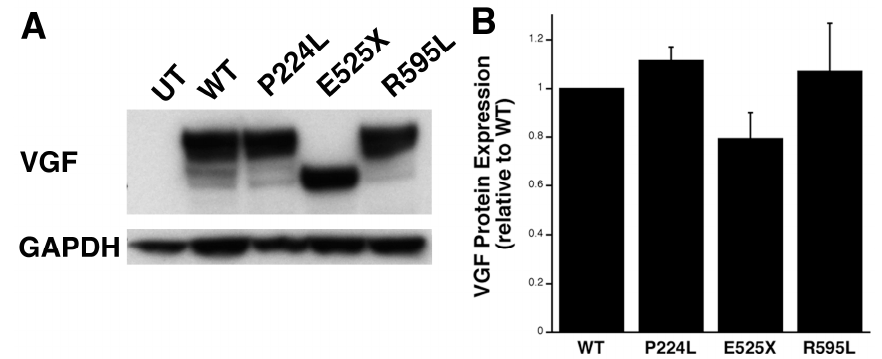
Figure 5. VGF Single Nucleotide Polymorphism (SNP) E525X results in truncated protein. ( A ) Representative Western blot of protein lysates from Human Endothelial Kidney (HEK) cells transfected with VGF plasmid containing either a mutation representing the P224L, E525X or R595L SNPs or Wild Type (WT) VGF , or Untransfected (UT). The blot was probed with VGF antibody and GAPDH was used as a loading control; and ( B ) quantification of protein expression for VGF plasmids in HEK cells. Bars represent average VGF protein levels normalized to GAPDH and expressed as a fold change relative to WT ± SEM. ( n = 3). Two-sample t test: WT vs. P224L t(4) = 2.04, p = 0.125. WT vs. E525X t(4) = − 1.80, p = 0.137. WT vs. R595L t(4) = 0.386, p = 0.740.